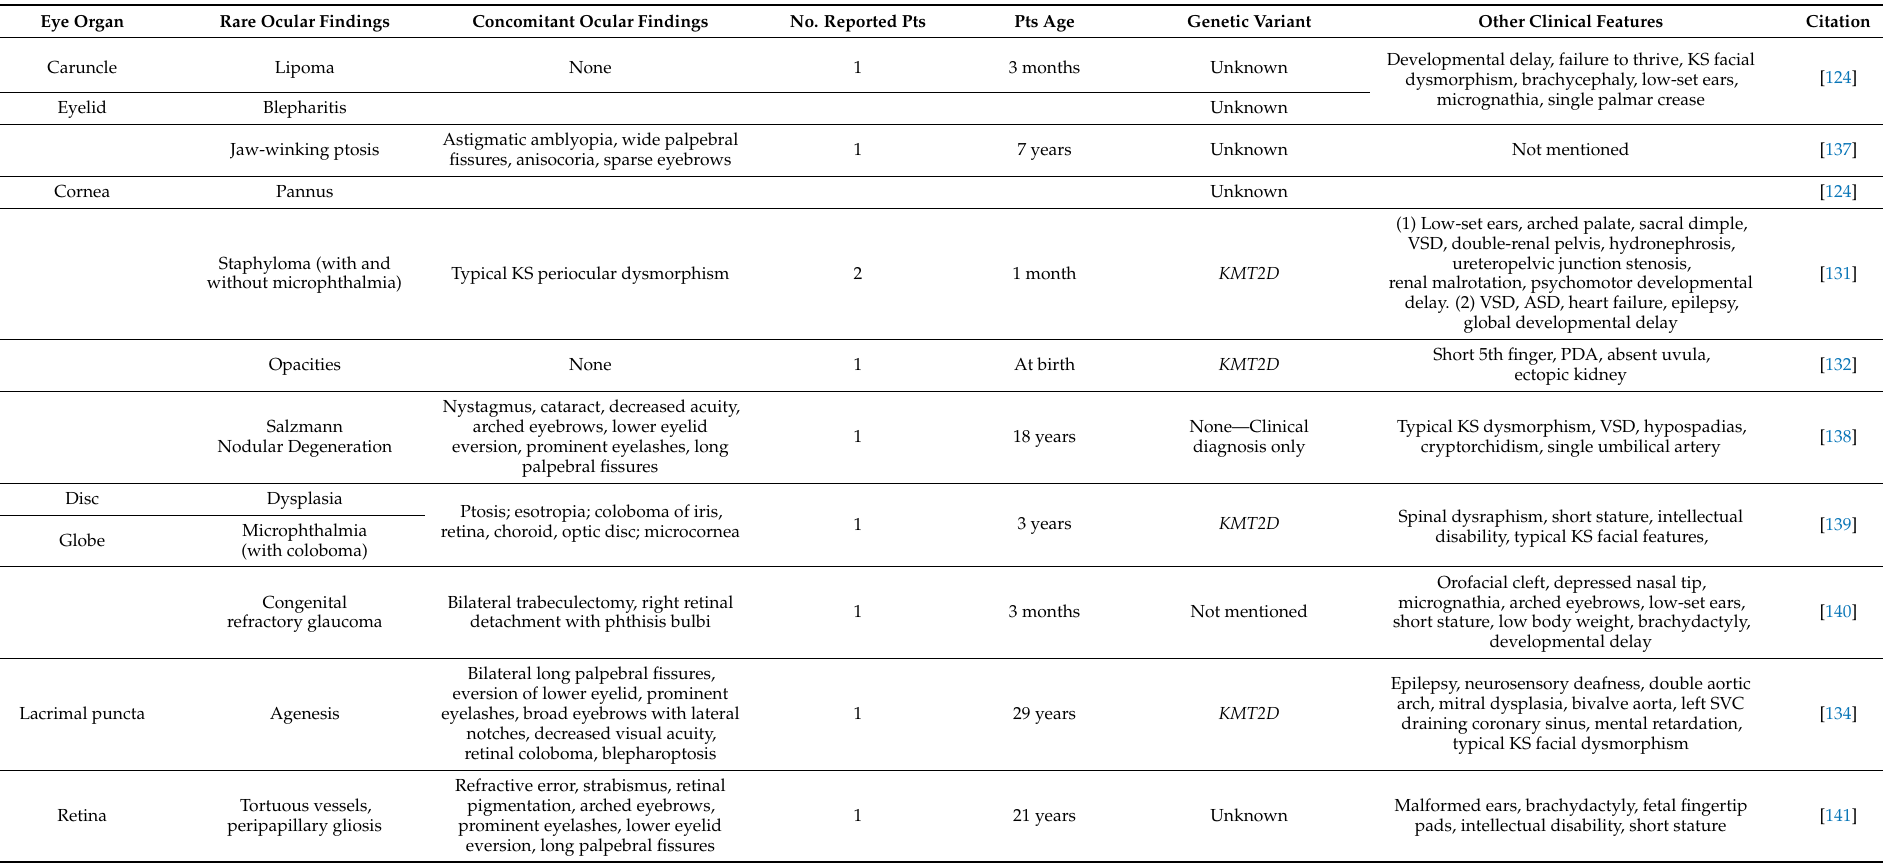
Table 3. Rarely reported significant ocular findings in KS patients. ADHD—Attention deficit and hyperactivity disorder AOM—acute otitis media; ASD—atrial septal defect; IgG— Immunoglobulin-G; VSD—Ventricular septal defect; PDA—patent ductus arteriosus, SVC—superior vena cava; UTI—urinary tract